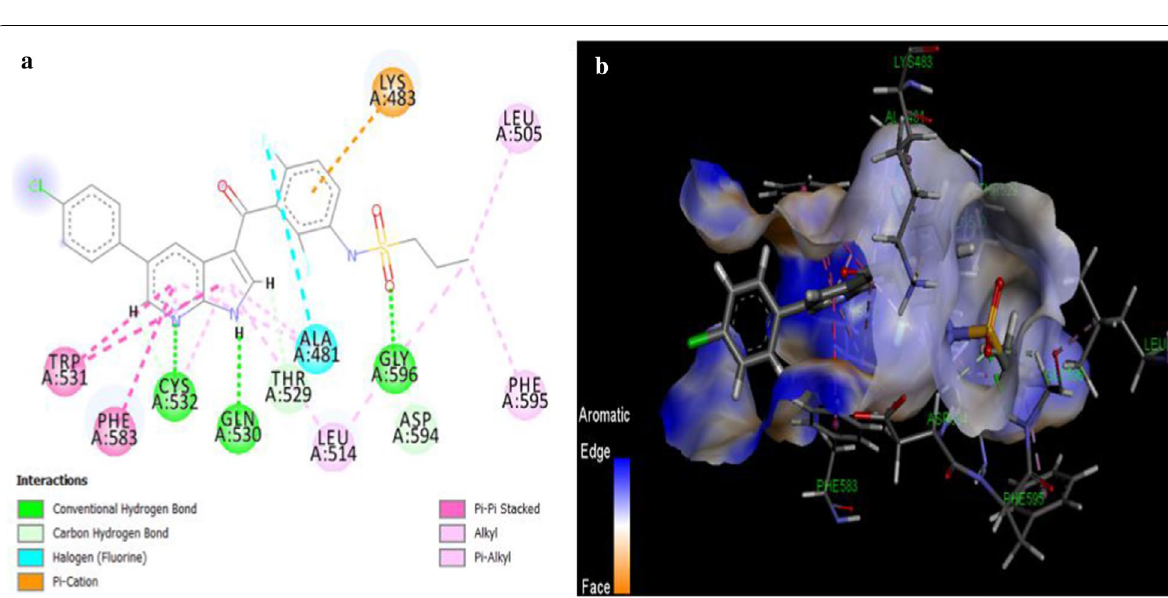
Fig. 6 a 2D diagram for the interaction of vem, with V600E-BRAF, b 3D diagram of vem, in the binding site of